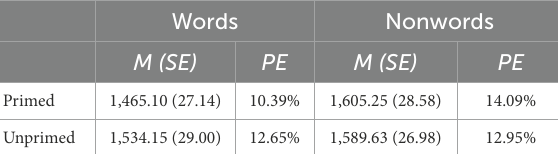
TABLE 2 Mean reaction times (in ms) and percent errors (PE) for words and nonwords by priming for Experiment